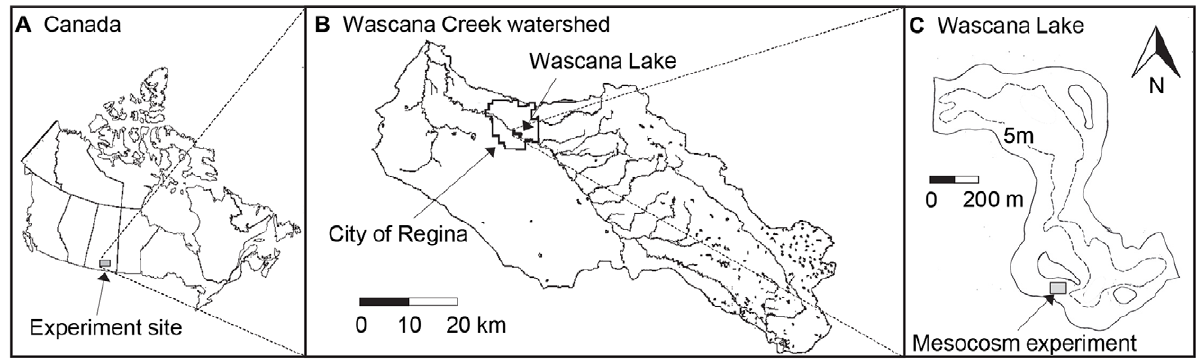
Figure 1. Map of Wascana Lake, Saskatchewan, Canada. Map shows a) the continental location, b) the gross drainage area (1400 km 2 ) and c) depth contour map with the location of the mesocosm experiment (shaded